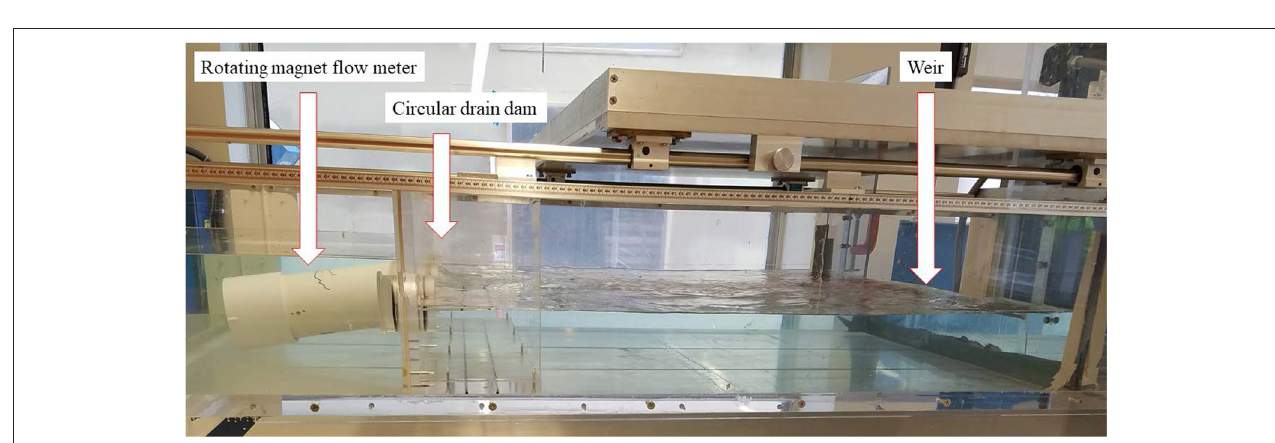
FIGURE 15 | Flow calibration test setup for rotating magnet flow